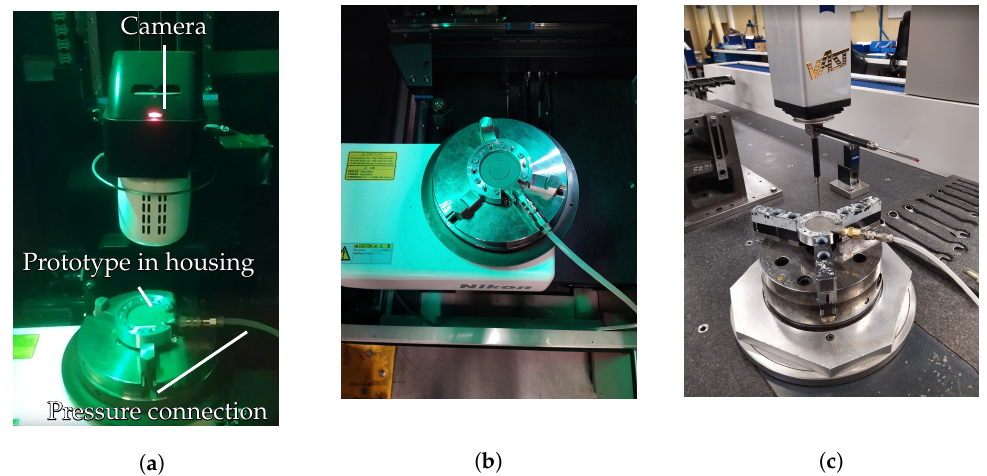
Figure 3. Pictures of the actuator in the Nikon HN-C3030 scanning system and Zeiss CMM machine. ( a ) Front view of the prototype positioned in the Nikon HN-C3030 metrology scanning system. ( b ) Top view of the prototype positioned in the Nikon HN-C3030 metrology scanning system. ( c ) Side view of the prototype positioned in the Zeiss CMM